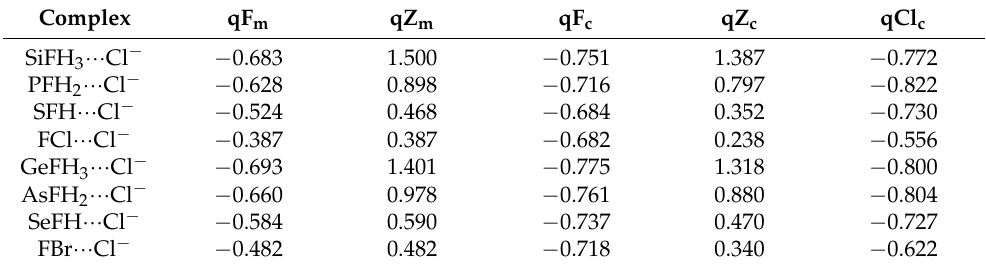
Table 2. NBO charges (in au) of the centres of the complexes analysed in this study. qCl c is the charge of the chloride anion involved in the interaction in the complex (for a free anion, this charge is equal to − 1 au). qF c and qZ c are the charges of the F and Z centres in the complex, while qF m and qZ m are these charges in the isolated Lewis acid